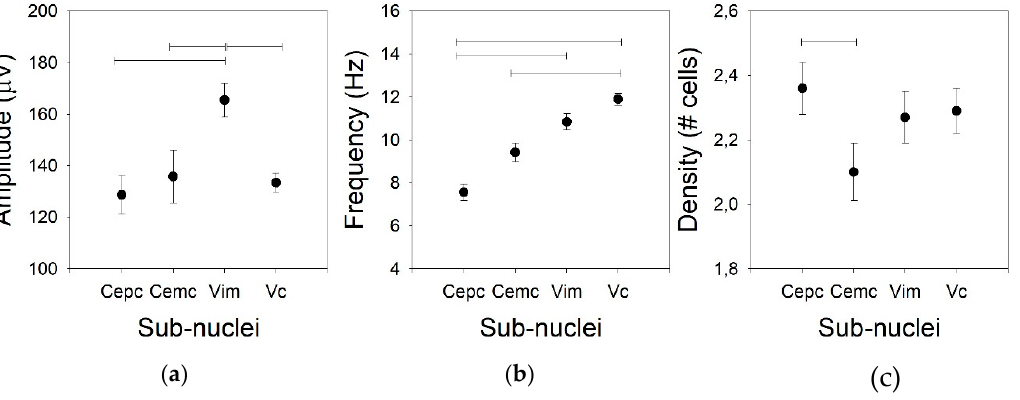
Figure 1. Tonic properties for the four nuclei. ( a ) Amplitude of the action potential (AP), ( b ) mean frequency of the raw traces, and ( c ) density of the cells. Horizontal lines indicate statistically significant differences between pairs of nuclei based on the Kruskal–Wallis analysis of variance test.